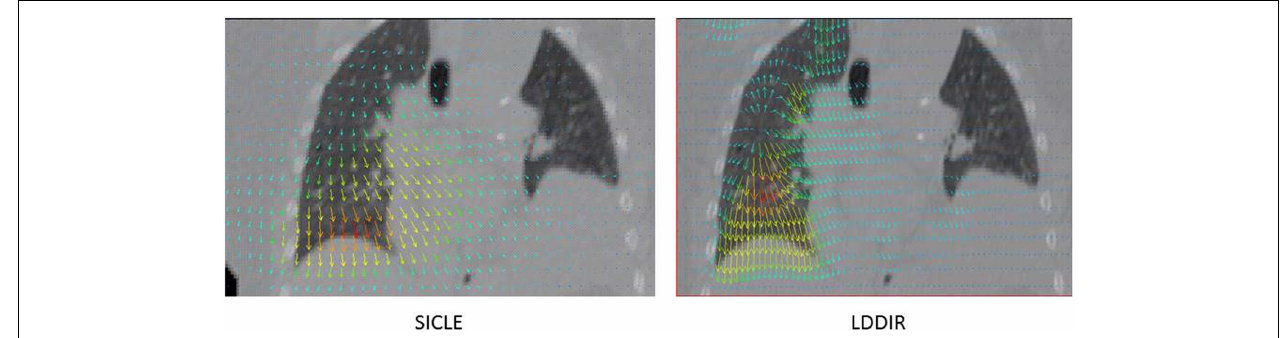
FIGURE 1 | Example of visualization of DIR results obtained with two algorithms on the same anatomy . SICLE algorithm (9) on the left hand side and LDDIR (3) algorithm on the right hand side.